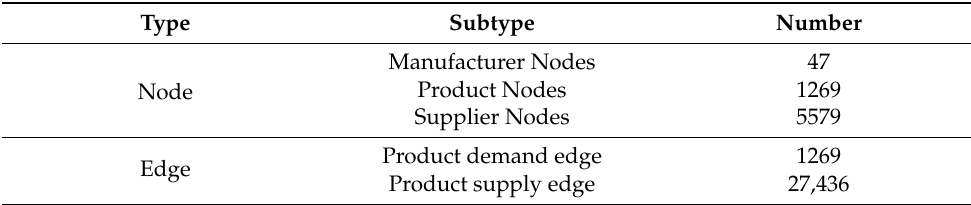
Table 1. Basic characters of the empirical supply